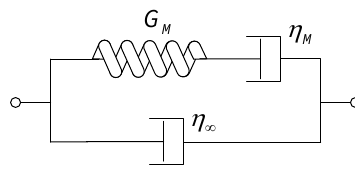
Figure 1: Mechanical analog of Model